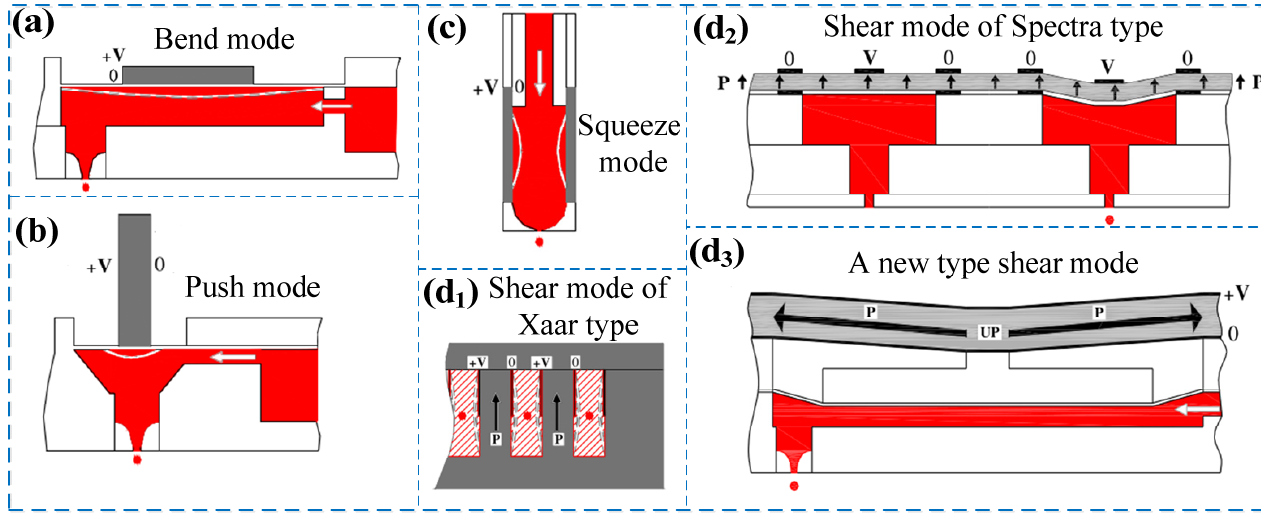
Figure 1. Structure diagram of the piezoelectric micro jet device [24]: ( a ) Bend mode, ( b ) Push mode, ( c ) Squeeze mode, ( d1 , d2 , d3 ) Shear mode. Reprinted with permission from Ref. [24]. Copyright 1991 IOP Publishing,